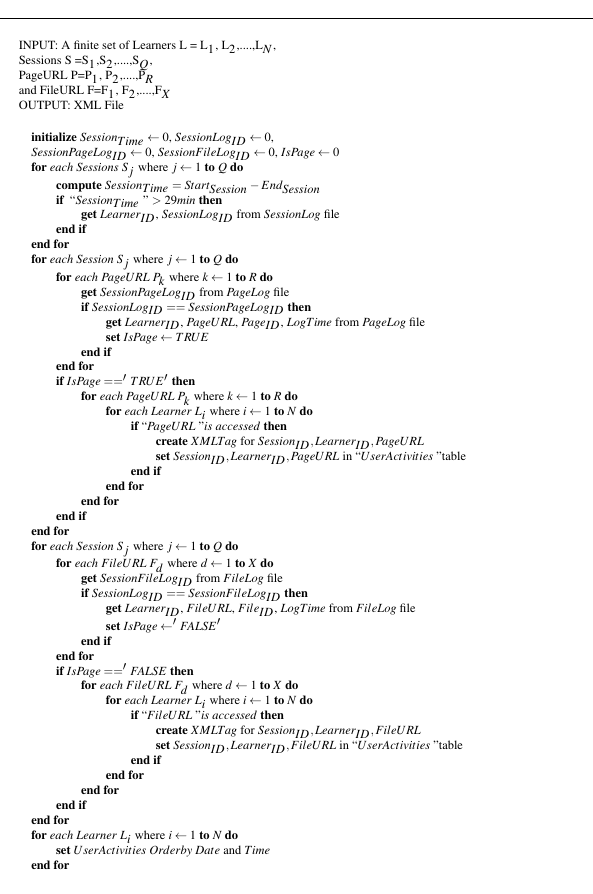
Algorithm 2: XML File2 Generation Algorithm